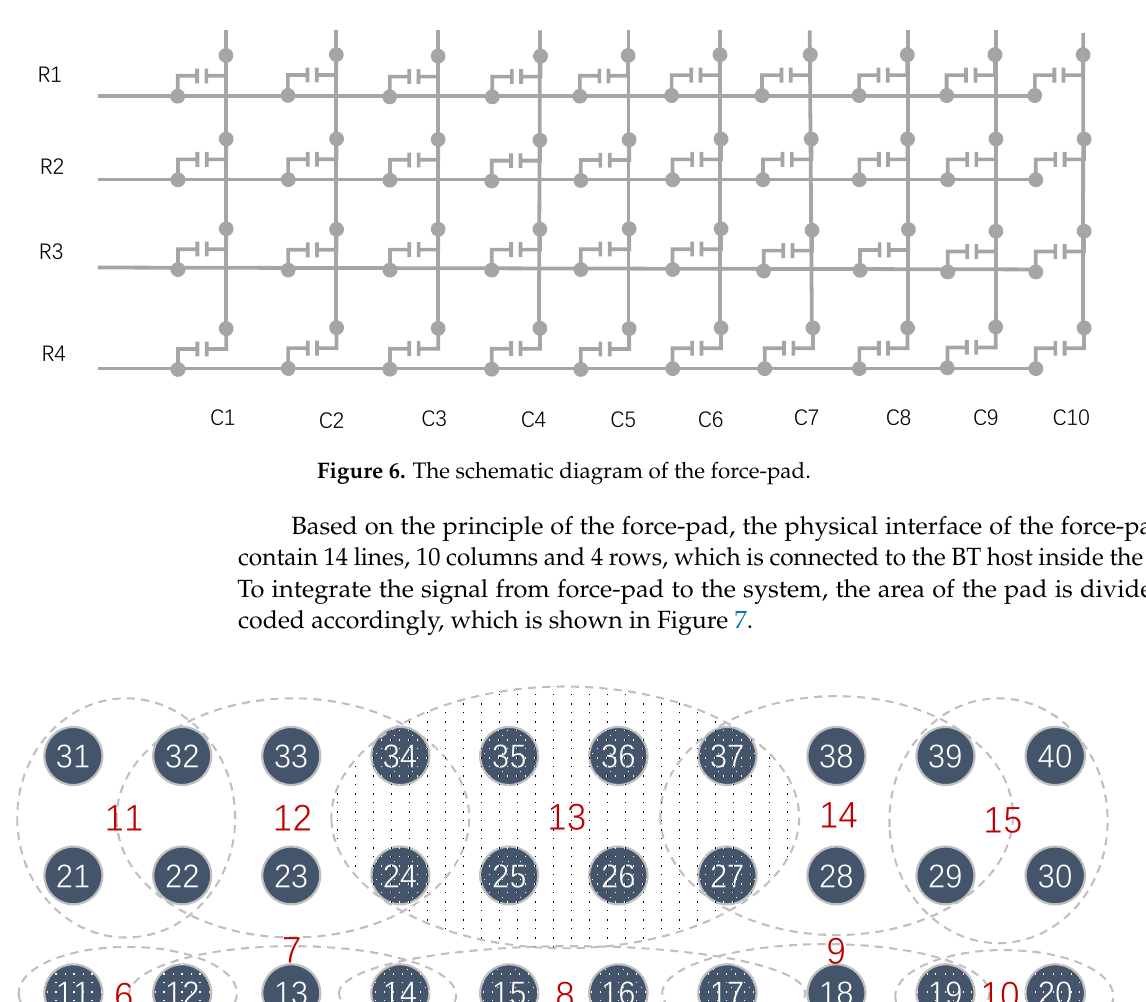
Figure 5. Picture of the force-pad from RoxiFSR Inc., Changzhou, China (http://www.roxifsr.com/productinfo/1018397.html).